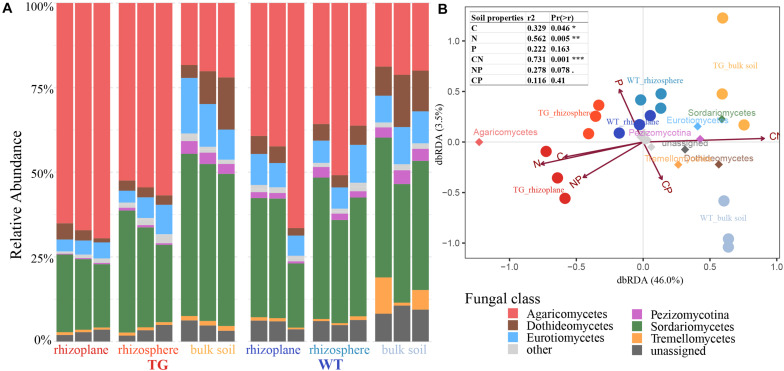
(A) Fungal relative abundance with class of each compartment of two sugarcanes, with three repetitions in each compartment. (B) Distance-based redundancy analysis of different zones, abundant classes, and six environmental factors (arrows) indicates the dominant communities and influential environmental factors.